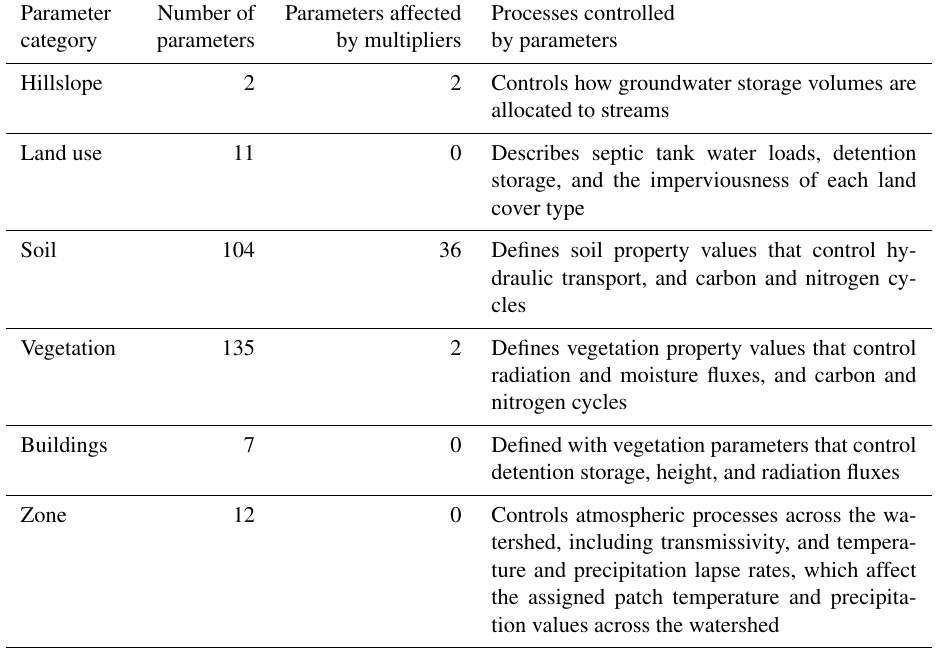
Table 2. RHESSys parameter categories, the processes modeled in those categories for this study, the number of unique parameters in each category, and the number of parameters that can be adjusted by built-in RHESSys parameter